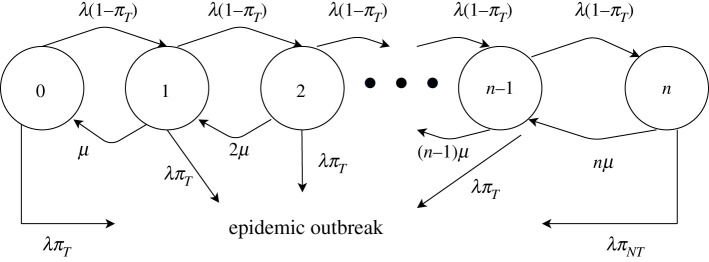
Simplified model of an epidemic outbreak with contact tracing. This diagram outlines the basic evolution of a disease from emergence to epidemic outbreak in the presence of a contact tracing system. When the system is imperfect, each traced case has a positive probability of leading to an epidemic, regardless of the arrival rate of new cases, the rate at which cases are processed or the number of cases that can be processed at once. When the system is effective, an outbreak will only occur if the system's capacity is limited and not all newly arriving cases can be processed.